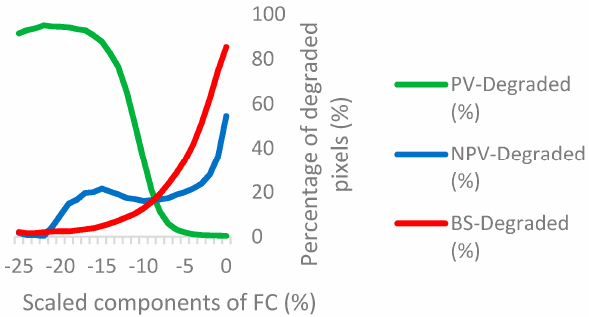
Figure 4. The percentage of degraded pixels across a gradient of low-to-high scaled components of fractional cover: scaled photosynthetic vegetation (scaled PV), scaled non-photosynthetic vegetation (scaled NPV), and scaled bare soil (scaled BS) cover.